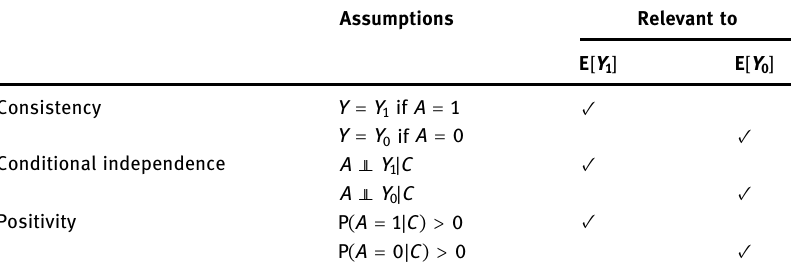
Table 2: Identifying assumptions for